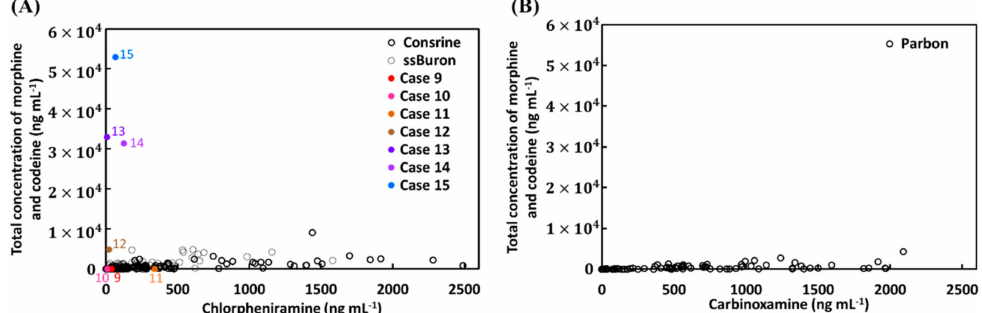
Figure 4. Distribution map of the total concentration of the sum of morphine and codeine against ( A ) chlorpheniramine and ( B ) carbinoxamine obtained from ten participants orally administered the cold syrups of Consrine, ssBuron, and Pabron, as well as those from seven people suspected of heroin abuse in cases